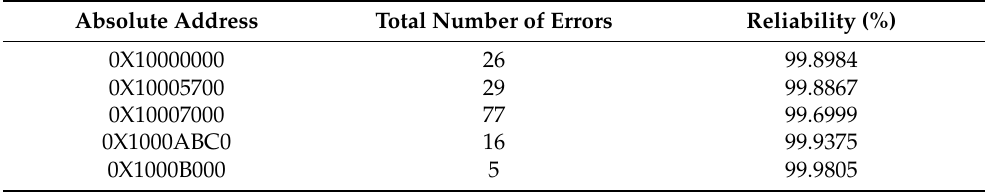
Table 2. Total number of errors and reliability of the five groups (redundancy coefficient = 0.05).